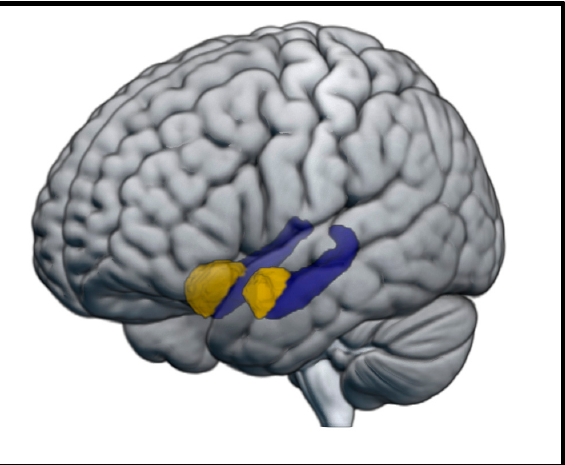
Figure 2. Volumetric Regions of Interest (ROIs). Bilateral hippocampus (purple) and bilateral amyg- dala control region (gold). Brain image and ROI visualization were generated using MRIcroGL [51].